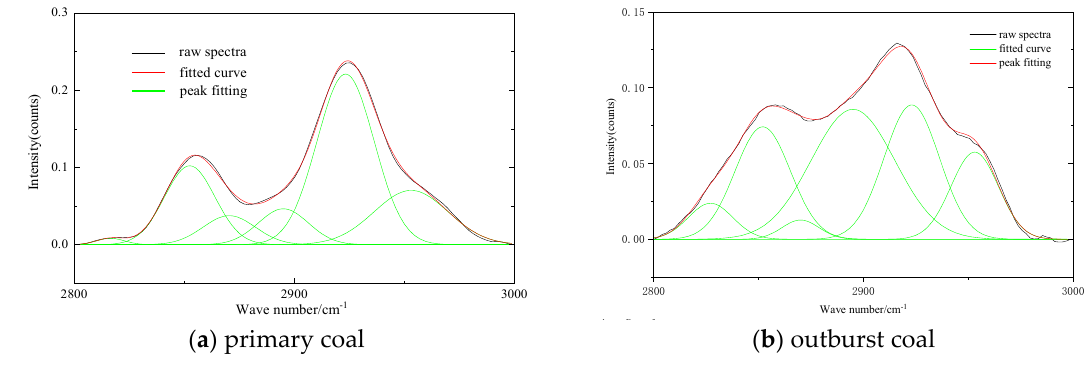
Figure 7. FTIR spectra of CHal